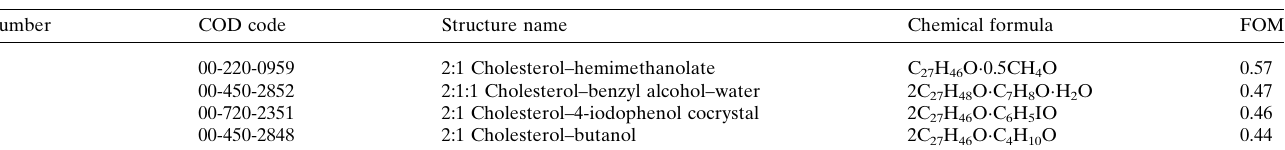
Table 1 Cholesterol structures screened to explain the experimental microdiffraction profile in Fig. 2( b ). During screening the structure with the highest FOM was